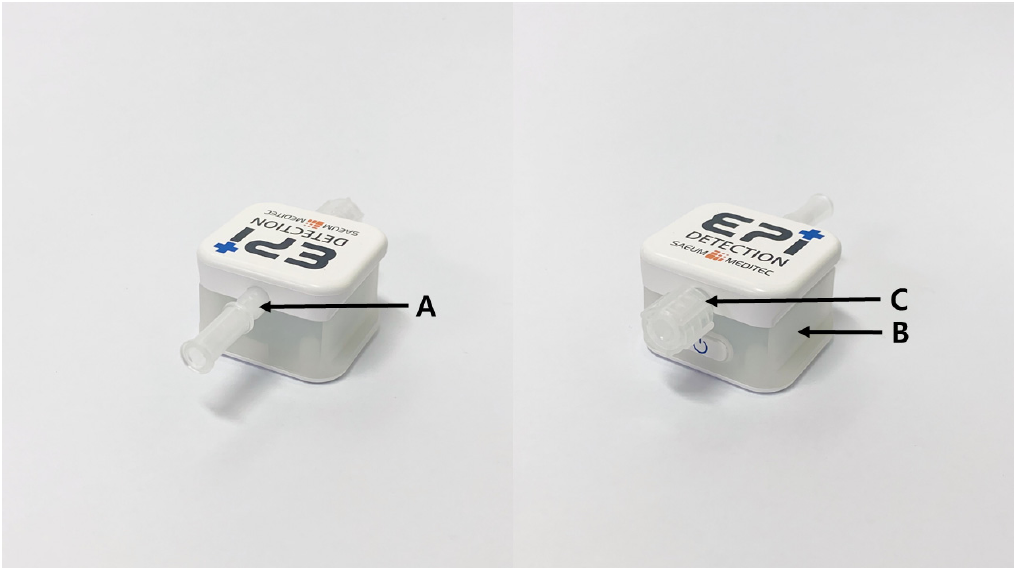
Figure 2. EPI-Detection TM device. It consists of a connection pipe ( A ) connected to a spinal needle,